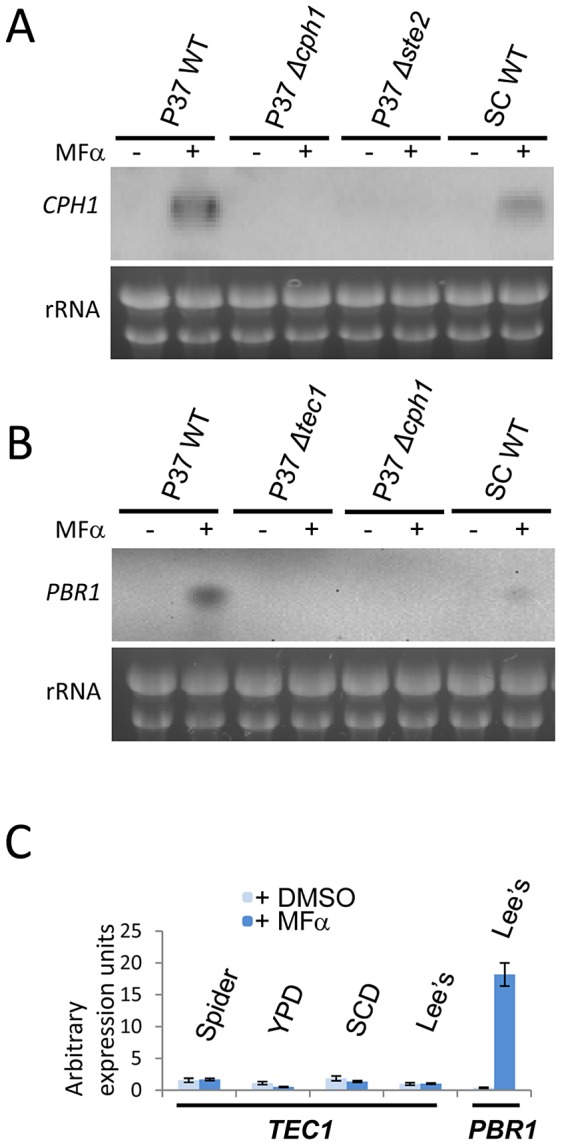
The CPH1 gene is up-regulated in C. albicans white cells responding to pheromone.Northern blotting reveals that (A) CPH1 is highly induced upon 10 µM α-factor treatment of P37005 white cells for 4 h in Spider medium. (B) PBR1 is also highly induced in white cells responding to pheromone. (C) Quantitative RT-PCR indicated that expression of the TEC1 gene did not change significantly following pheromone treatment under a variety of culture conditions. Each data is the mean ± SD from two independent experiments with at least three replicates. Light blue bars on graphs, no pheromone added. Dark blue bars, MFα pheromone present. (WT P37005: CAY716; Δcph1/Δcph1: CAY2899; Δtec1/Δtec1: CAY2506; Δste2/Δste2: CAY1234; WT SC5314: RBY717). P37 indicates strain derived from P37005, SC indicates derived from SC5314.